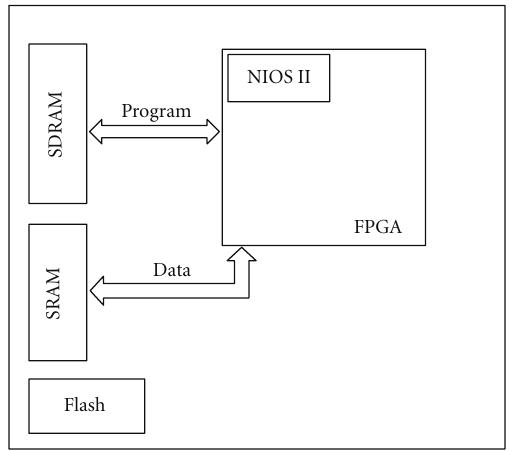
Figure 5: A NIOS II processor embedded into an FPGA chip.